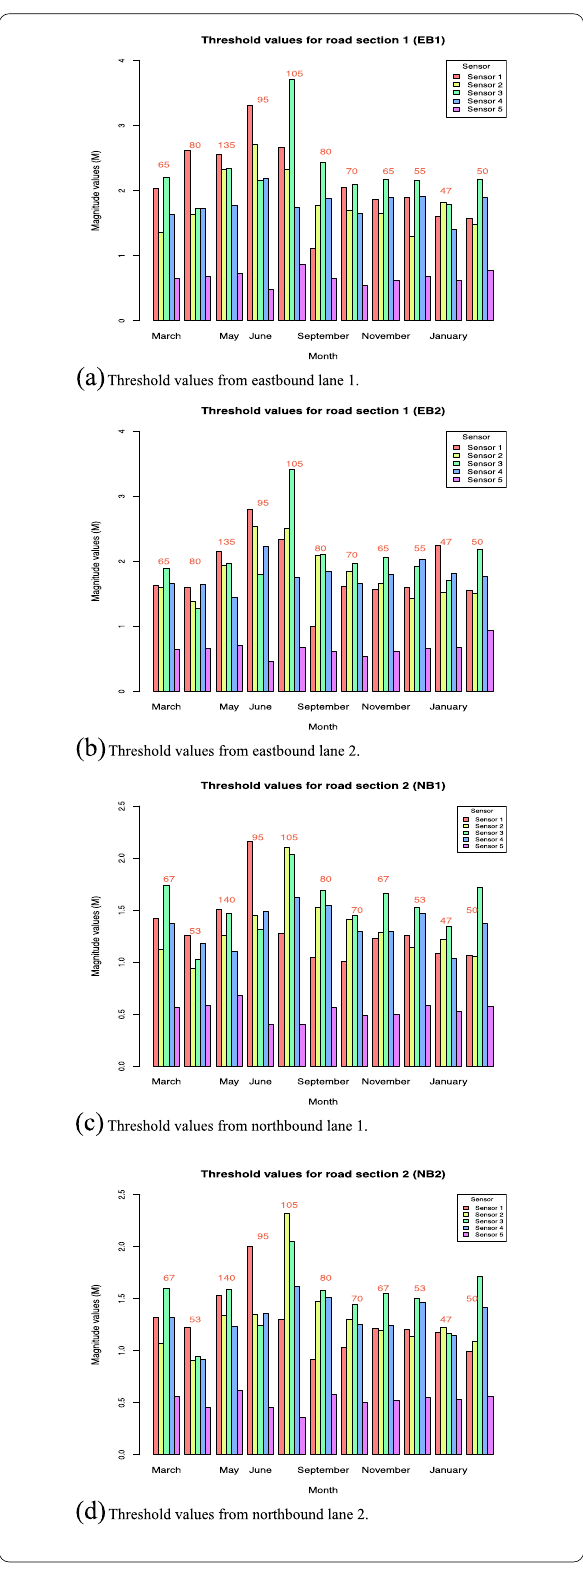
Fig. 5 Threshold values for two road sections. a Threshold values from eastbound lane 1. b Threshold values from eastbound lane 2. c Threshold values from northbound lane 1. d Threshold values from northbound lane 2. Note: the values on the top of the bar plot indicate the pavement temperature